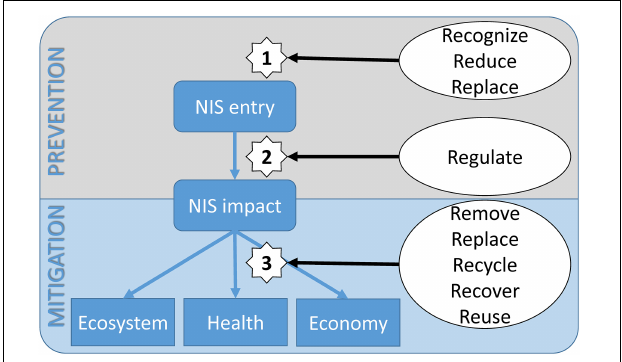
FIGURE 3 | Conceptual diagram of non-indigenous species invasion flow (rounded boxes), their impact (boxes), and the possible steps (1–3) of the 8Rs prevention and mitigation measures (in